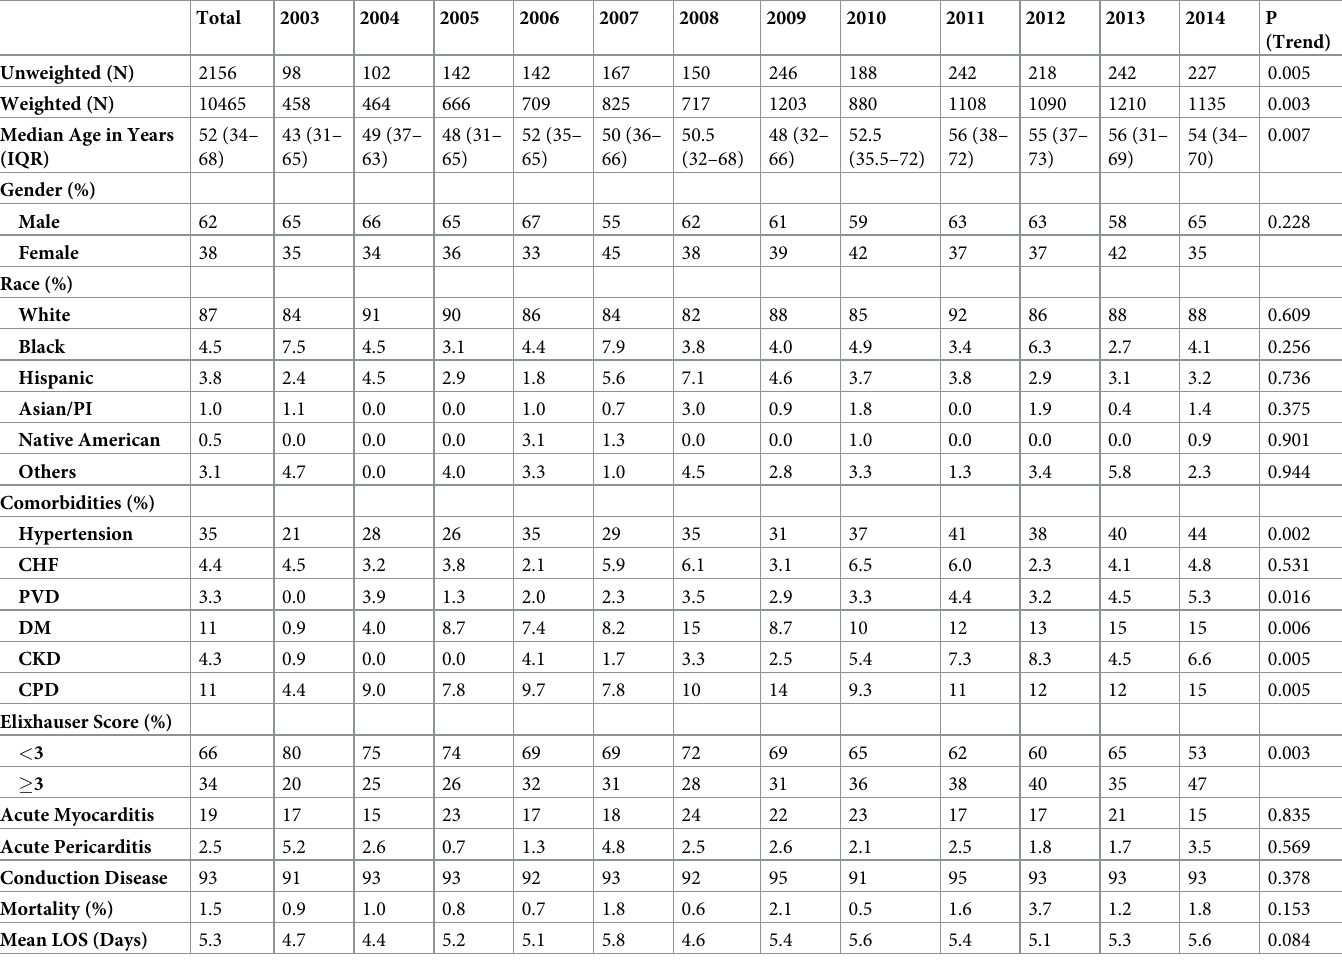
Table 2. Trends in baseline characteristics of patients hospitalized with Lyme carditis in the U.S. between 2003 and